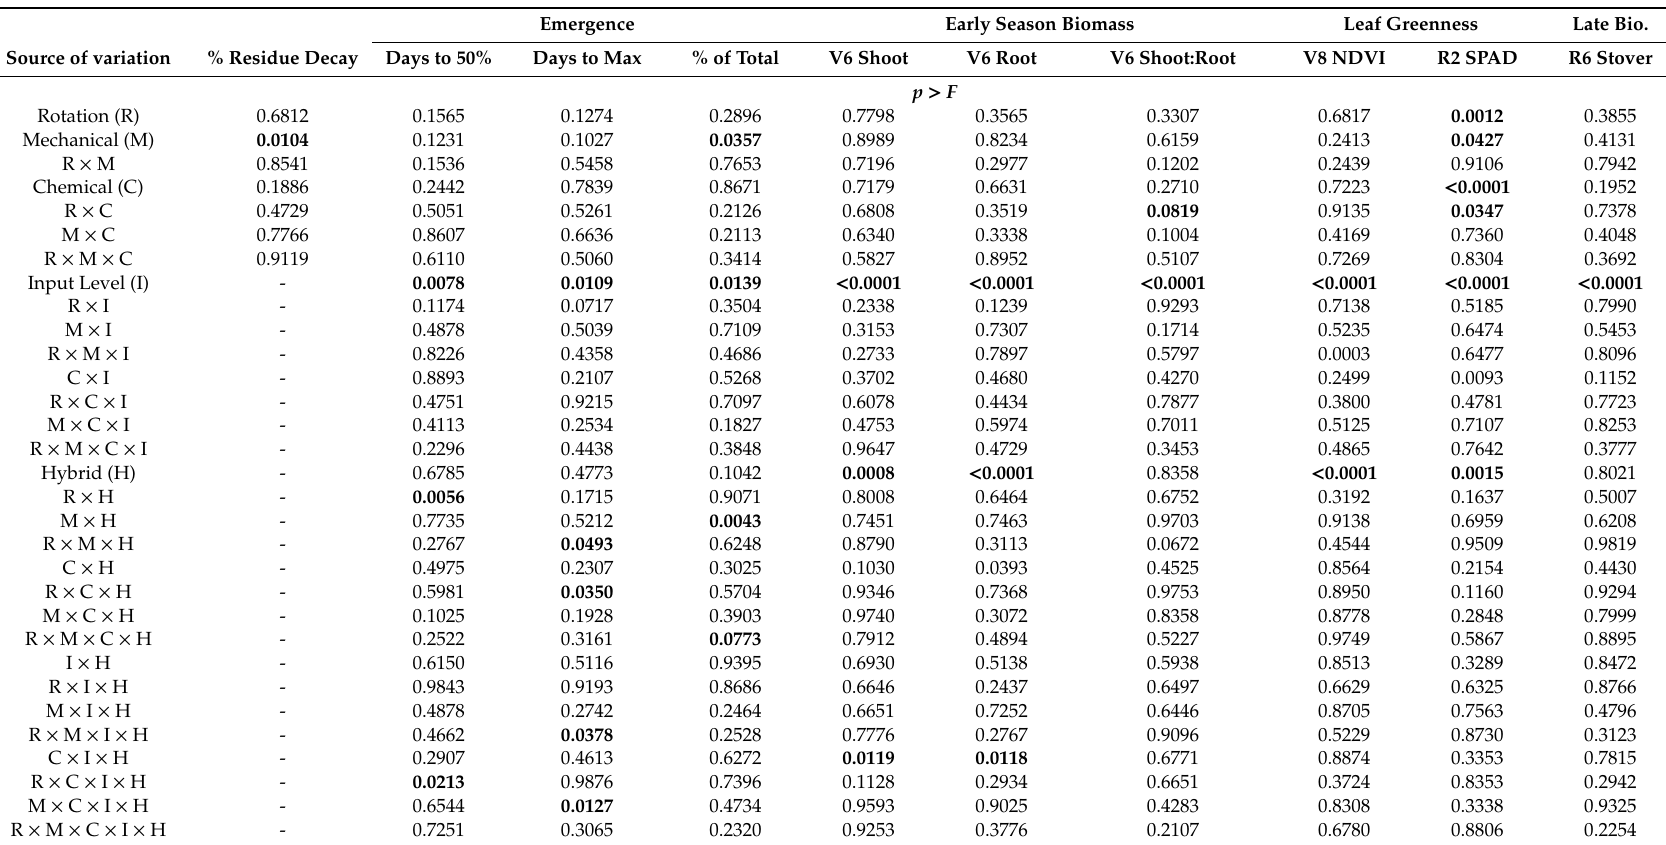
Table 3. Tests of fixed sources of variation on corn residue decomposition, seedling emergence, biomass accumulation, and leaf greenness (crop vigor) at various plant growth stages (V6, V8, R2, and R6) as a ff ected by two crop rotations, two mechanical and three chemical residue managements, two input levels, and two hybrids at Champaign, Illinois during 2017 and